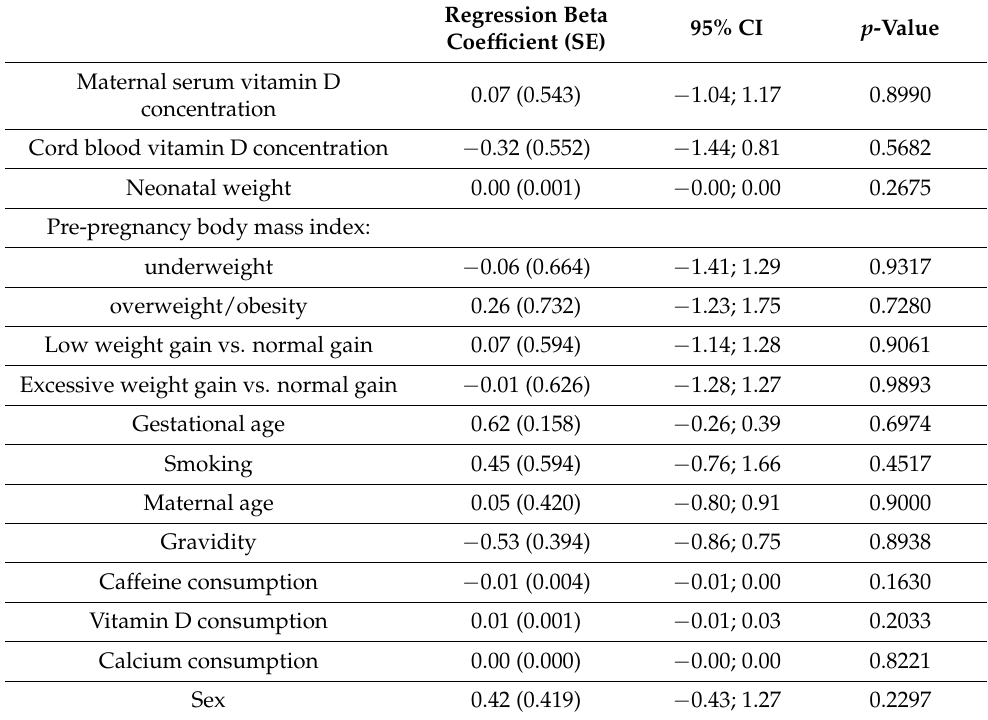
Table 2. Relationship between selected parameters and weight at the age of 2.